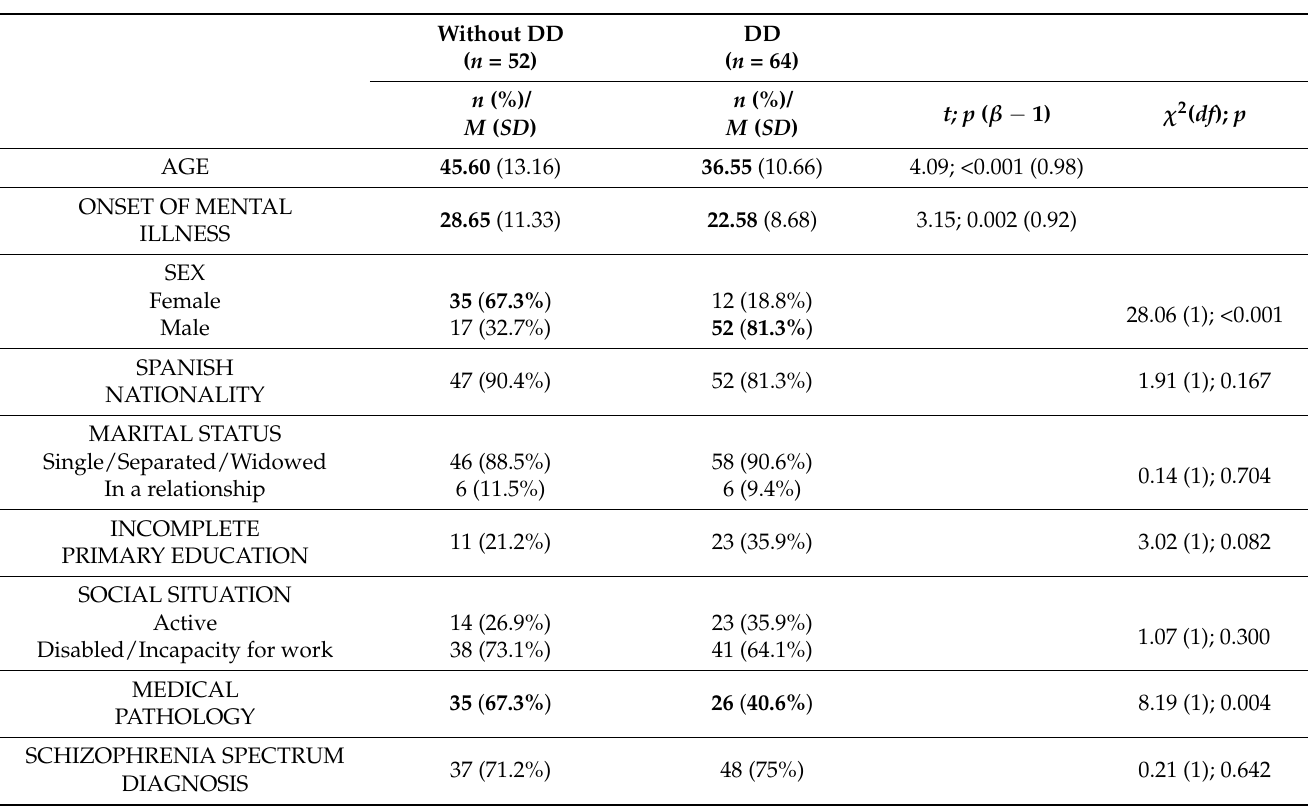
Table 1. Differences in the sociodemographic and clinical variables of patients with or without dual disorder